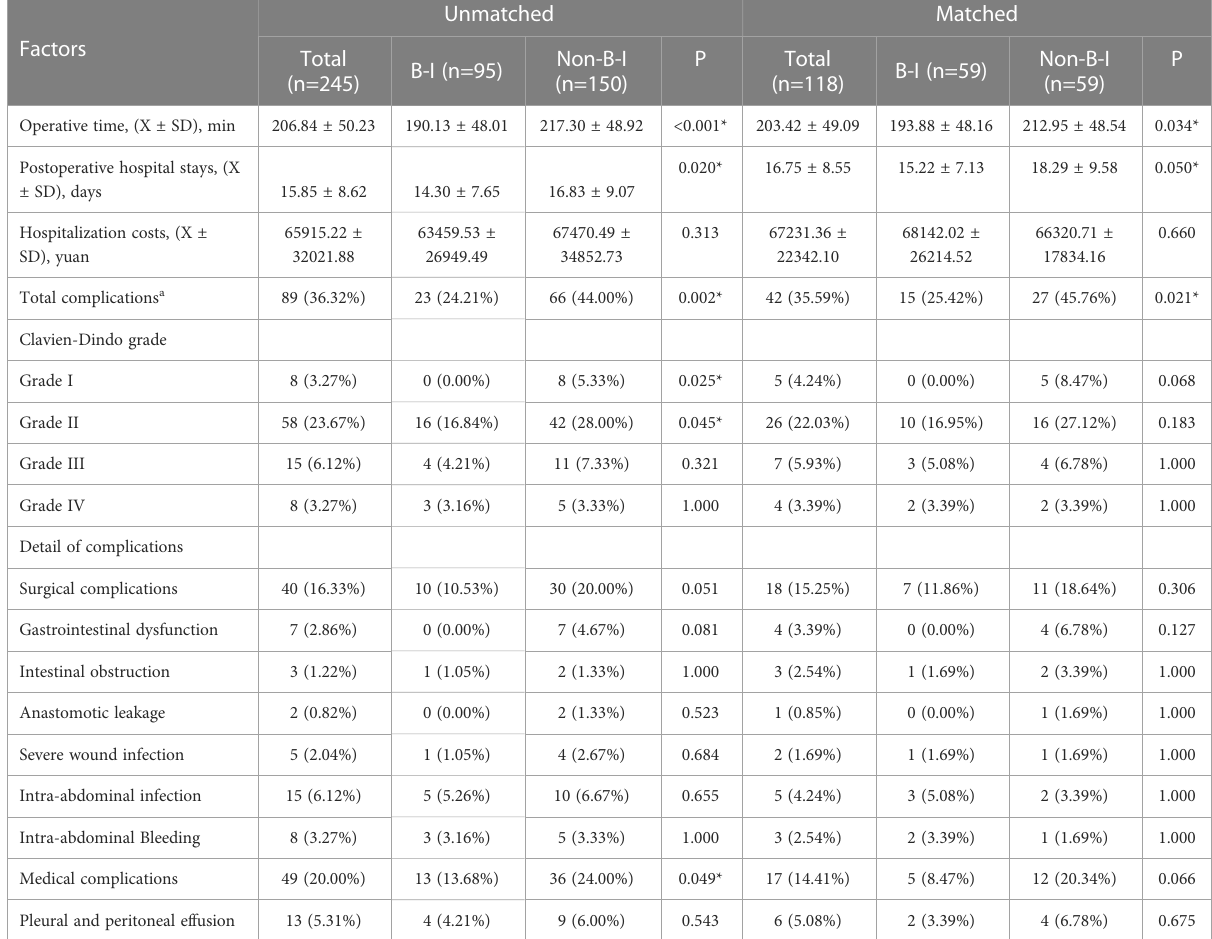
TABLE 3 Surgical outcomes before and after